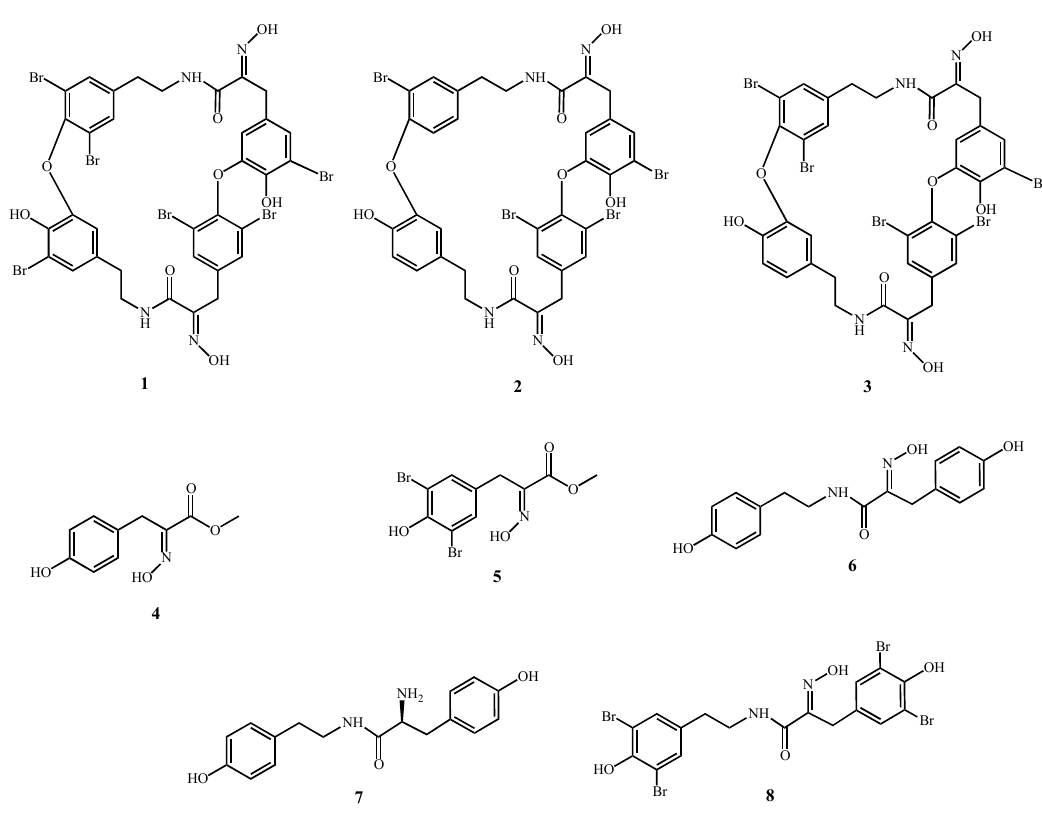
Figure 1. Compounds under